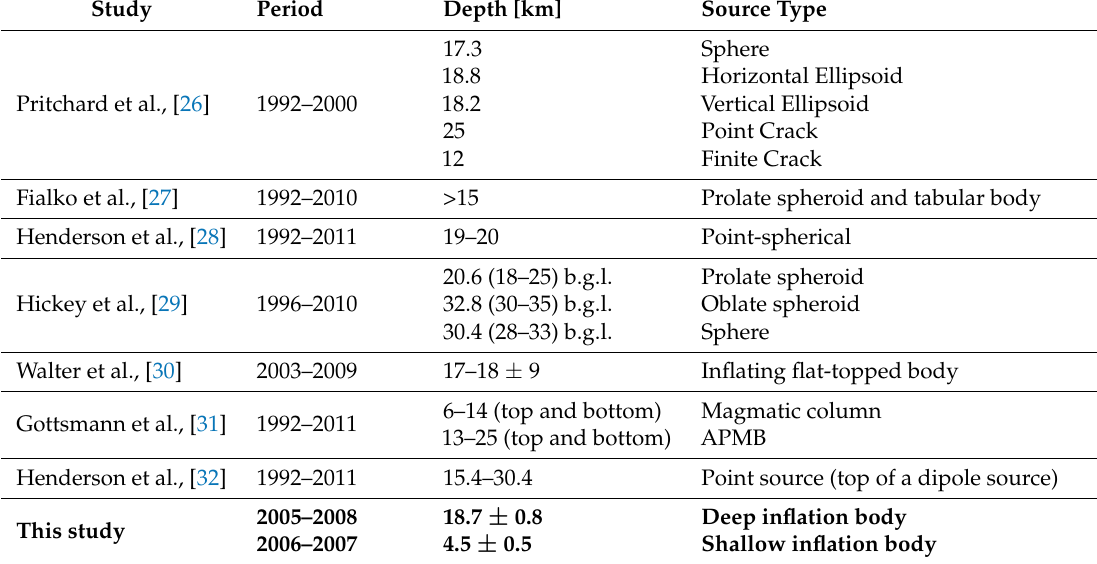
Table 2. Summary of deformation sources. Volcanic source modeling for APMB and Uturuncu volcano retrieved from satellite geodetic measurements. Where not specified, depths are referred to sea